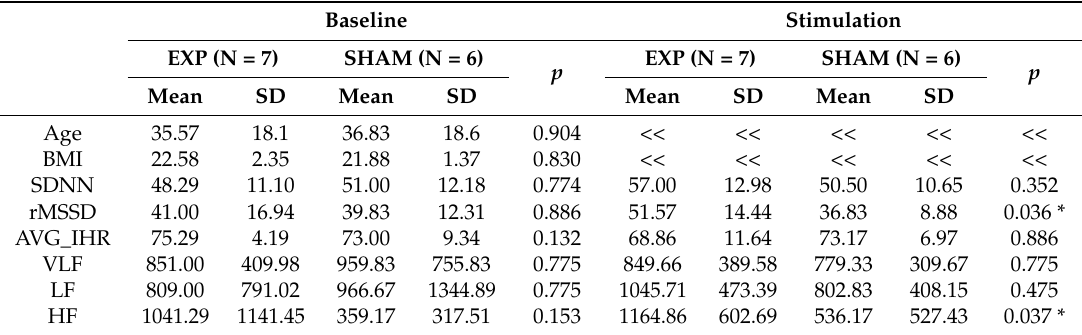
Table 2. Results for the experimental (EXP) and control groups